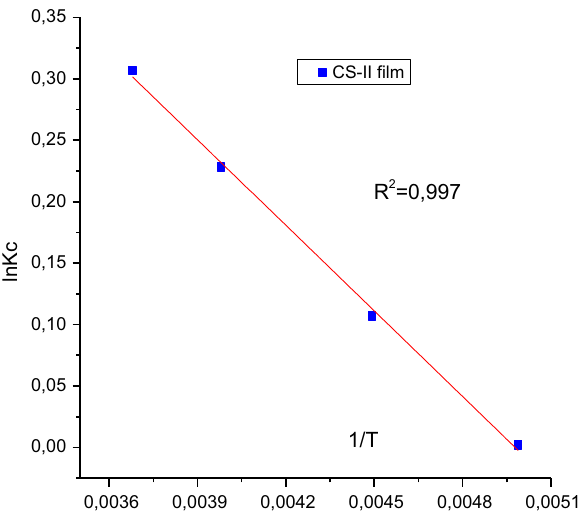
Fig. 8 Plot of ln K against 1/ T